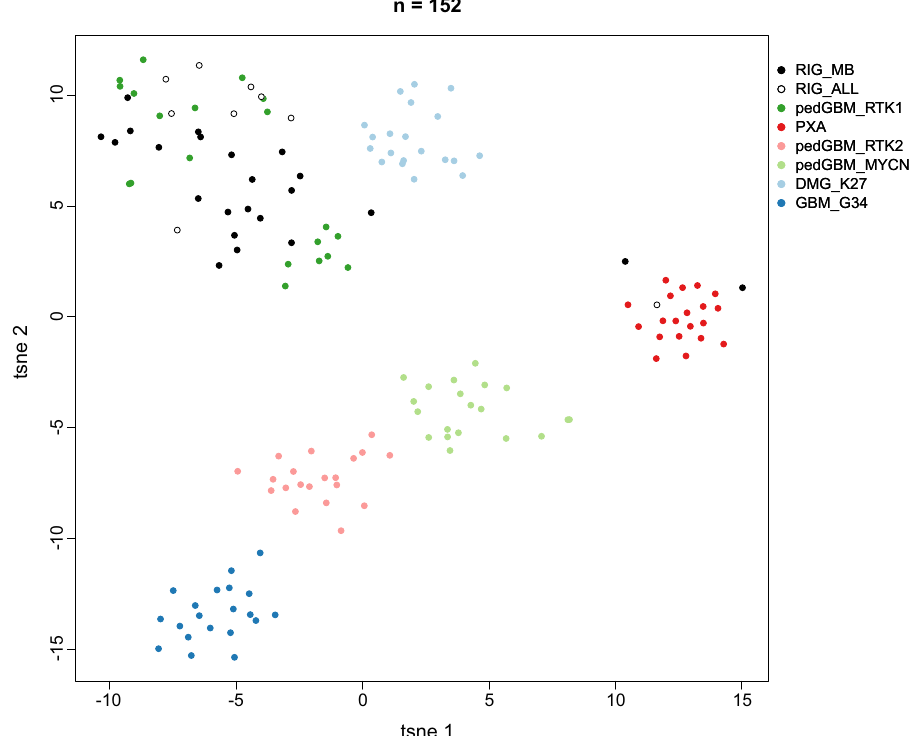
Fig. 3 Molecular classi fi cation of RIGs by DNA methylation pro fi ling. Unsupervised analysis of 32 RIG tumors was conducted based on the 10,000 most variably methylated probes. Through a t-SNE analysis, the majority of RIG tumors form a homogenous group of tumors resembling the pediatric GBM RTK1 group. ALL-RIG and MB-RIG samples were compared with 120 well-characterized reference samples representing CNS tumors of known histological and/ or molecular subtype. PXA pleiomorphic xanthoastrocytoma, pedGBM_RTK1 pediatric glioblastoma subclass RTK1, pedGBM_RTK2 pediatric glioblastoma subclass RTK2, pedGBM_MYCN pediatric glioblastoma subclass MYCN, DMG_K27 diffuse midline glioma H3 K27 mutant, GBM_G34 glioblastoma, H3.3 G34 mutant.